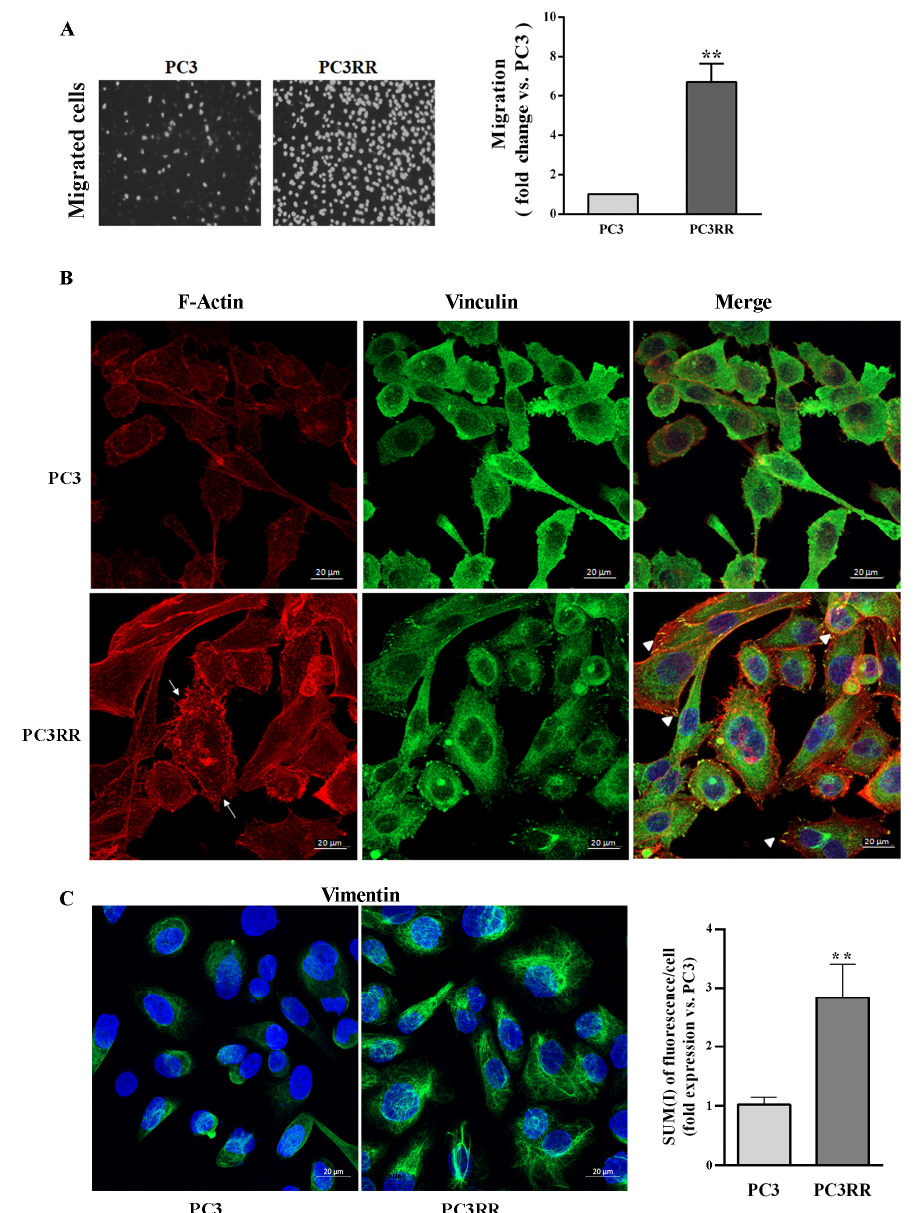
Figure 6. Migration capability and cytoskeleton organization of parental PC3 and PC3RR cells. ( A ) Representative images of trans-well migration 24 h after plating of DAPI-labeled PC3 and PC3RR cells (left). Data are expressed as the fold increase of migration rate relative to PC3 cells (set arbitrarily at one) (right). ( B ) Representative confocal micrographs showing distribution of F-Actin in red (Rhodamine phalloidin), vinculin in green (FITC) and nuclei in blue (TOPRO-3). In PC3RR cells, arrows indicate the lamellipodia and filopodia, and arrowheads indicate Vinculin colocalization with Actin filaments to form focal adhesions (scale bar 20 µm). ( C ) Representative confocal micrographs showing staining of Vimentin in green (FITC) and nuclei in blue (TOPRO-3) (scale bar 20 µ m). Graph indicates fluorescence intensity of vimentin, (SUM(I)/cell) performed using Zeiss software. Data are expressed as the mean ± S.E.M. derived from at least three independent experiments. Statistical significance ** p < 0.01; PC3RR vs. PC3 Student’s unpaired t